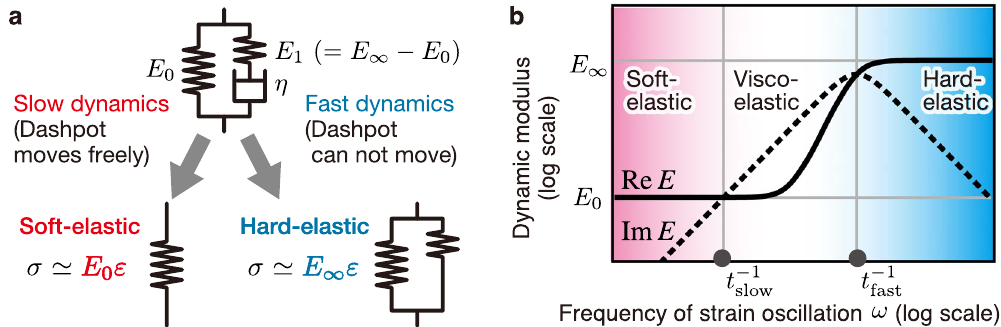
and η  t E / . In the fast slow 0